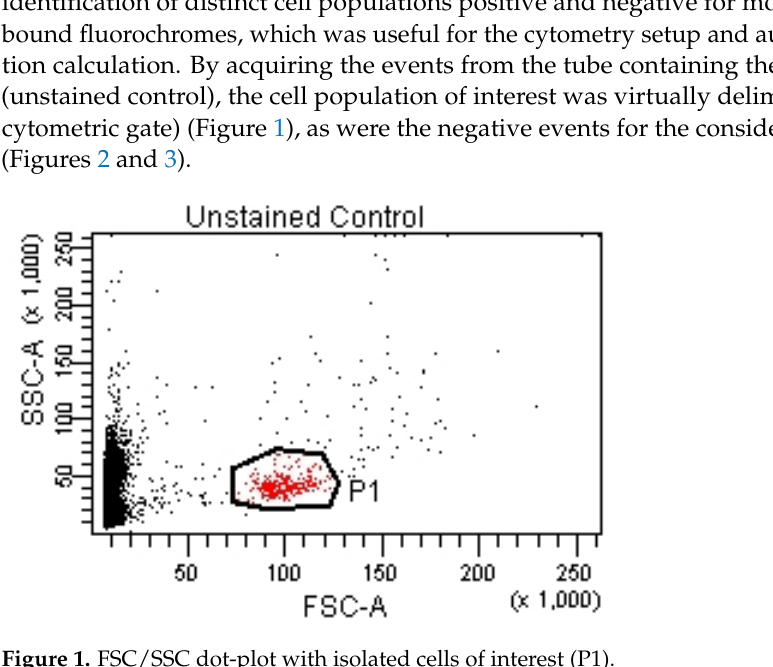
Figure 1. FSC/SSC dot-plot with isolated cells of interest (P1). In an FSC/SSC dot-plot histogram, a P1 gate containing the cells of interest was created. Negative events for the fluorochromes used in the experiment can be visualized using the corresponding histograms (Figures 2 and